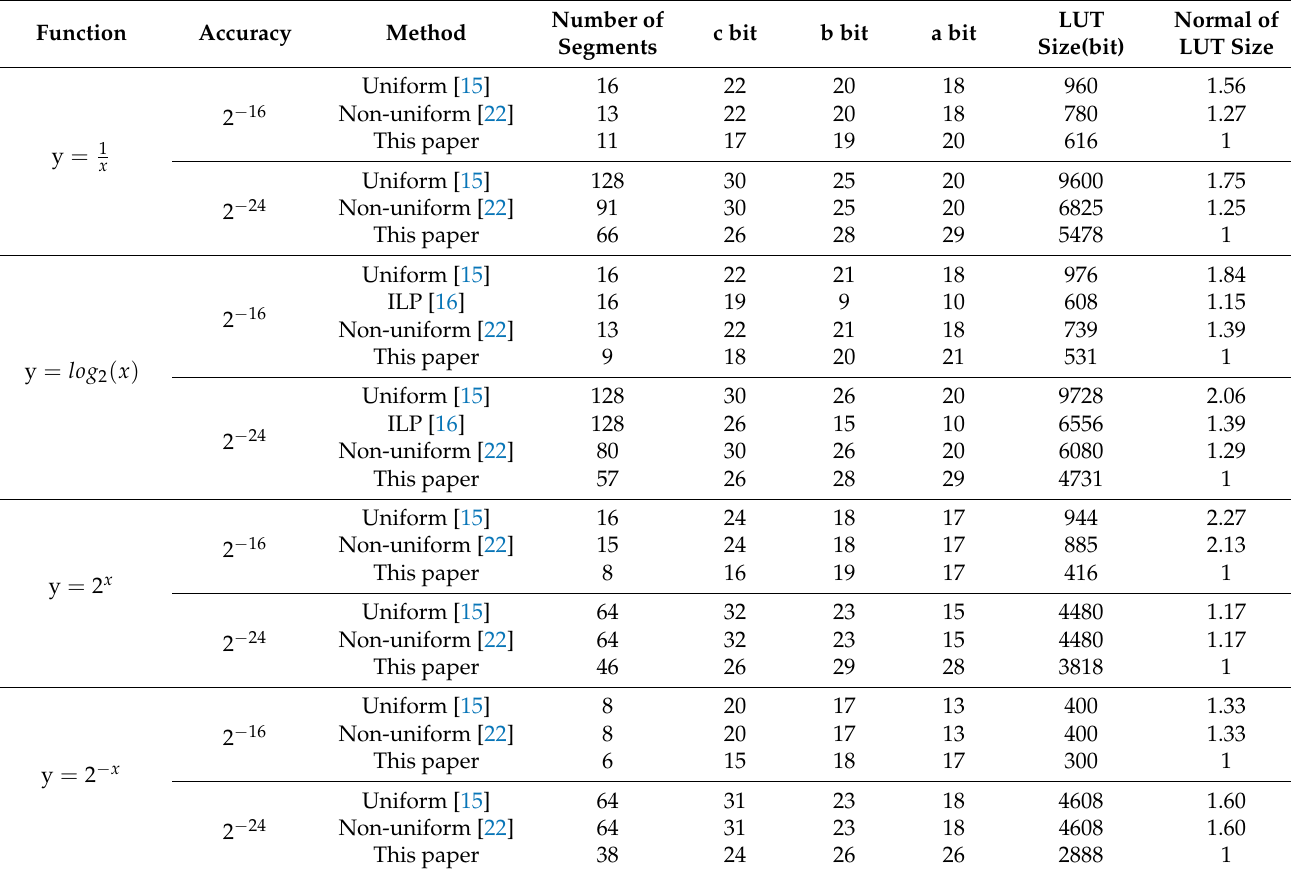
Table 4. Comparison in segments, LUT size, and coefficient width.